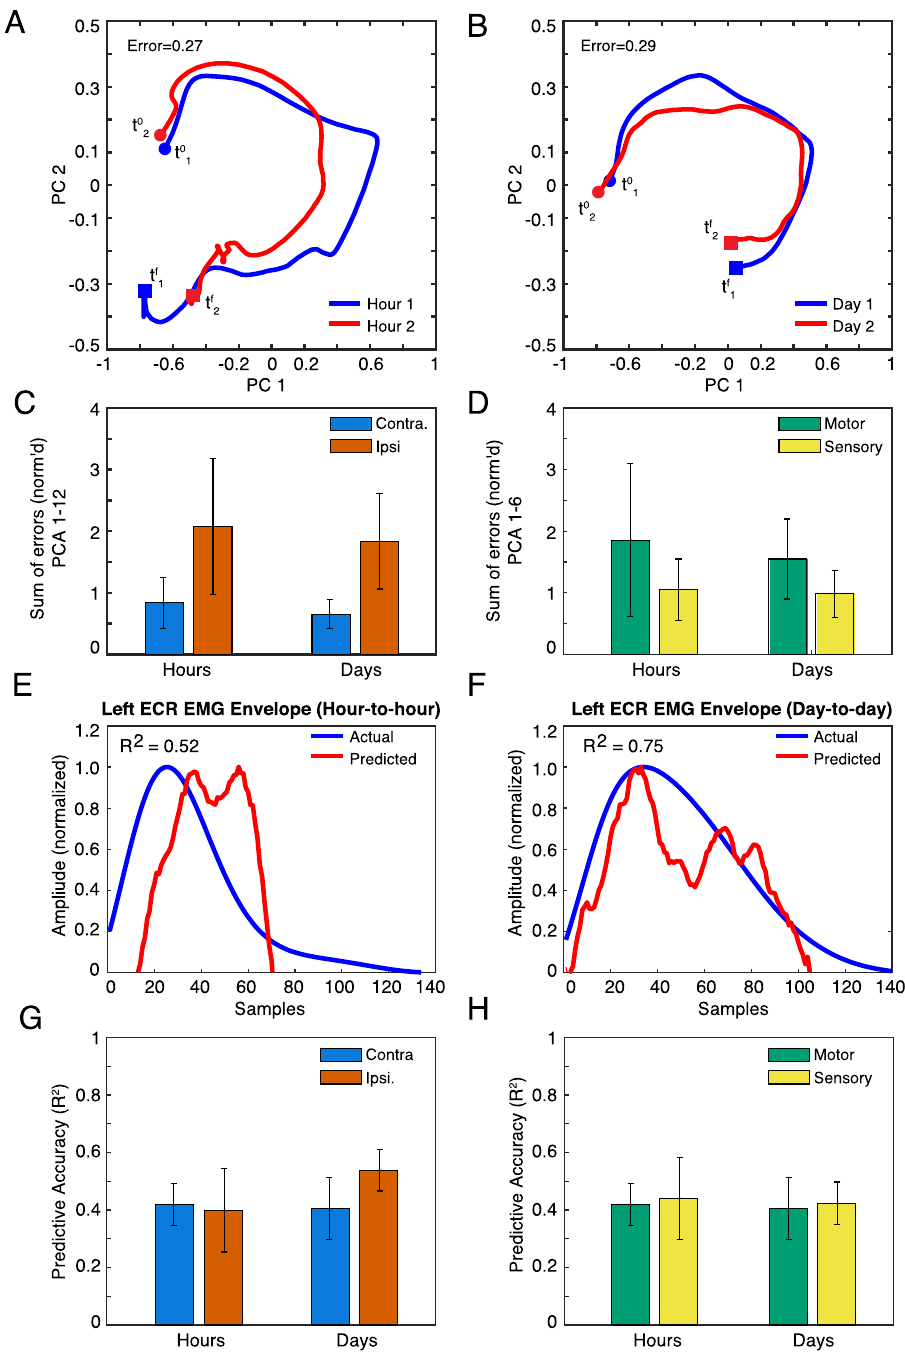
Figure 5. Ensemble-level (network) stabilities of left-ECR-related activity over time. ( A – B ) Representative principal-component (PC) trajectories of neural ensemble, visualized in the PC1-PC2 plane, during left wrist extensions across typical sets of consecutive– hour ( A ) and consecutive–day ( B ) recordings, for the right (contralateral) hemisphere (i.e. motor and sensory channels aggregated). Trajectories reflect average neural activity within EMG bursts only, with endpoints designated at the onset (filled circles, variables t 0 ), and terminal points (filled boxes and variables t f ) of the burst. Error is a normalized Euclidean distance between trajectories, with higher values indicating greater instability (see Materials and Methods). ( C – D ) Cumulative error between trajectory representations of ensemble activity, comprising the first six PCs, between consecutive hours, and consecutive days (Mean + /− 1 s.e). Channel ensembles are grouped by brain hemisphere ( C ) and area ( D ). ( E – F ) EMG of left wrist extensor (ECR: extensor carpi radialis), as measured from surface electrodes (blue) and as predicted from PCA trajectories (PCs 1–6: red) using Wiener filters trained on separate data. Data shown are for test (measurement) and training datasets recorded over consecutive hours ( E ) and days (sessions) ( F ). All envelopes are restricted to between burst onsets and terminations, and were time warped to an equal length to facilitate analysis. The x-axis shows the resulting time axis (in samples). The y-axis gives normalized envelope amplitude (see Supplementary Information). R 2 signifies the correlation between the actual EMG and the prediction. ( G – H ) Correlations (R 2 ) between measured (actual) and predicted EMG, arranged by brain hemisphere ( G ) and area ( H ). As above, R 2 is based on training and test sessions spaced over consecutive hours and days